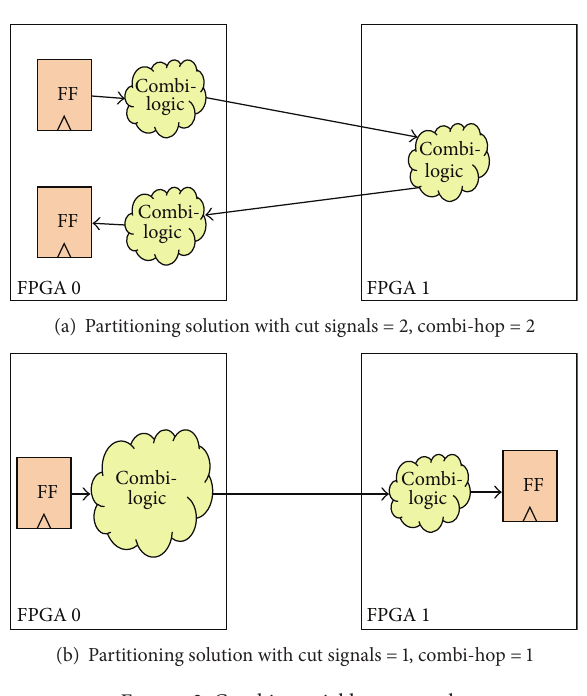
Figure 2: Combinatorial hop